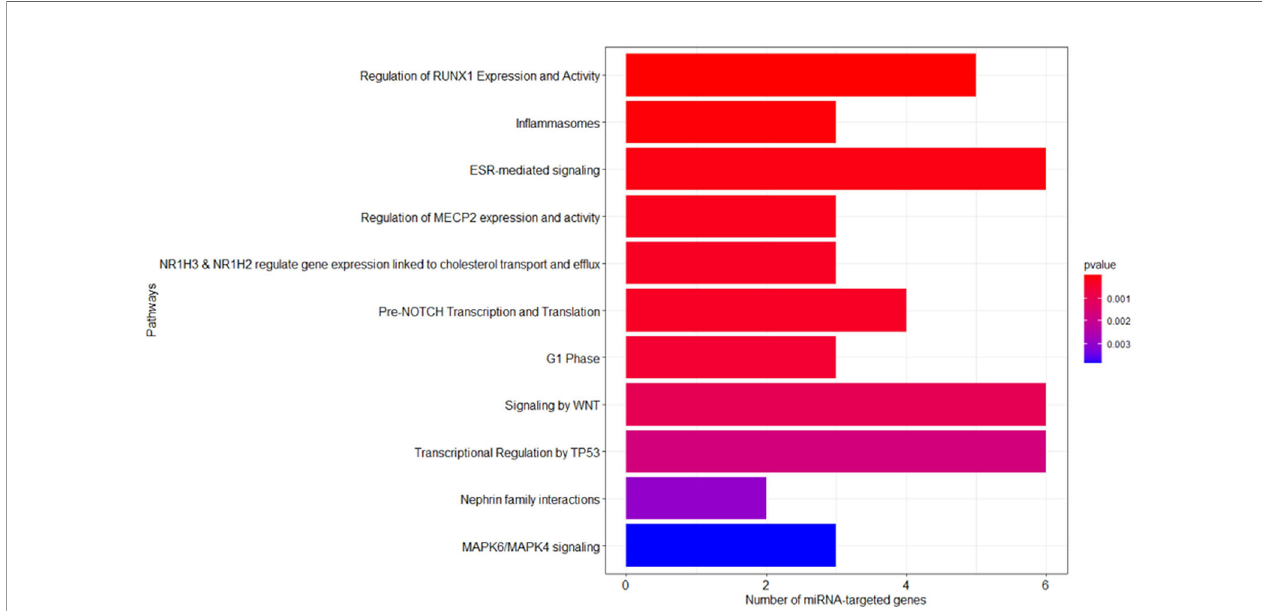
FIGURE 3 | Reactome enriched pathway analysis. The bar plots show the list of pathways sorted by their statistical signi fi cance; the adopted p-value is based on hypergeometric distribution and BH correction test. The gradient of the p-value goes from red (lower p-value of 2.6348E-09) to blue (higher p-value of 3.8487E-03). The x-axis reports the number of gene targets in each pathway.